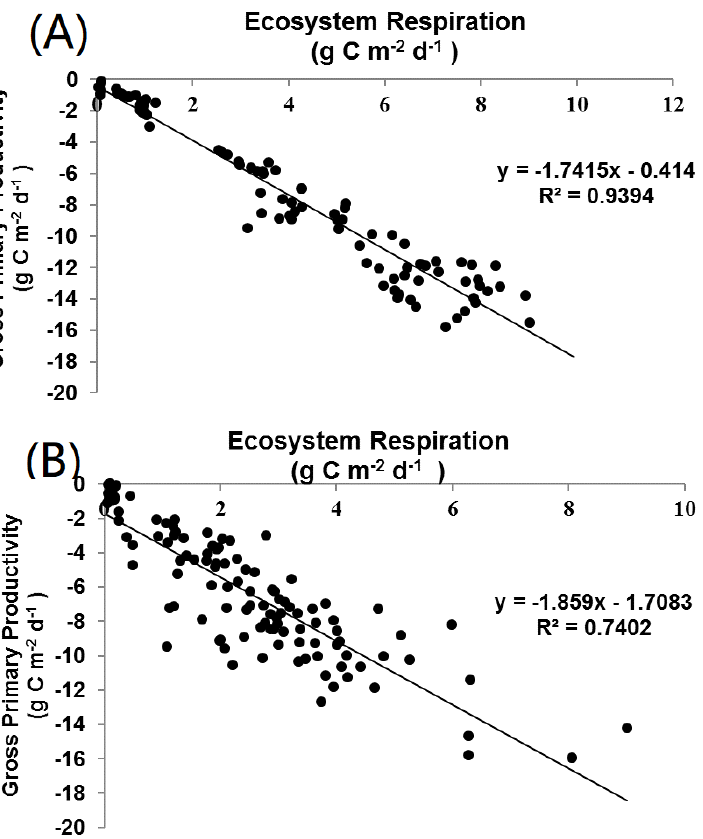
Figure 6. Scatter plot of daily ecosystem respiration (RE) and gross primary productivity (GPP) in (A) rice and (B) wheat over the crop season.